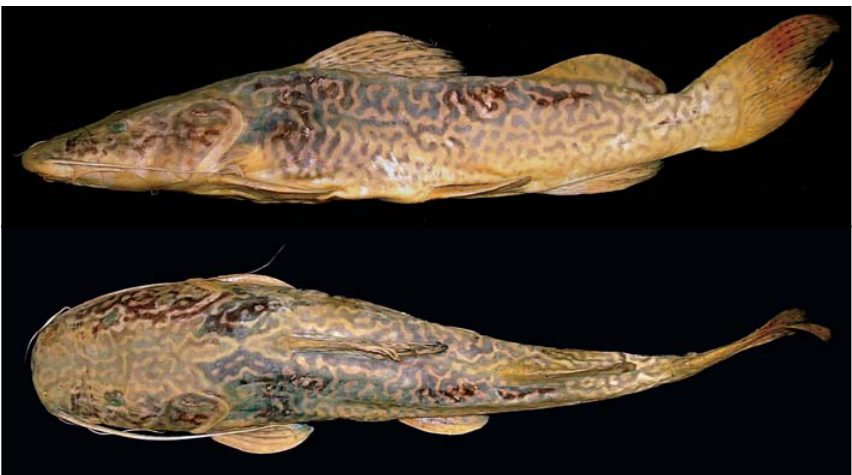
Fig. 5 . Lateral and dorsal views of S. doceanum. MZUSP 87988, 420 mm SL, Ponte Nova, rio Piranga, tributary of rio Doce, Minas Gerais, Brazil.